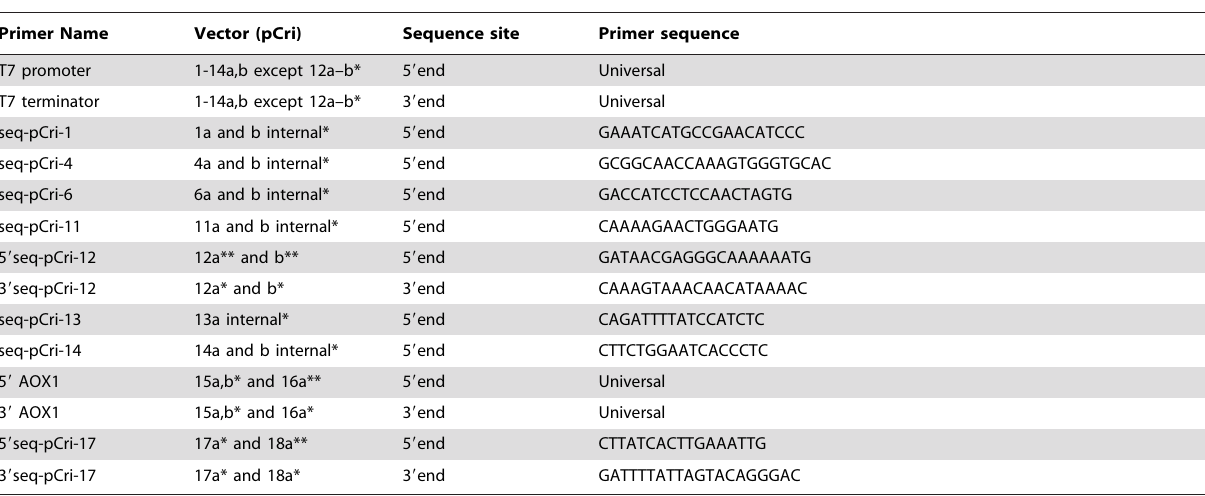
Table 4. Sequencing primers for the pCri